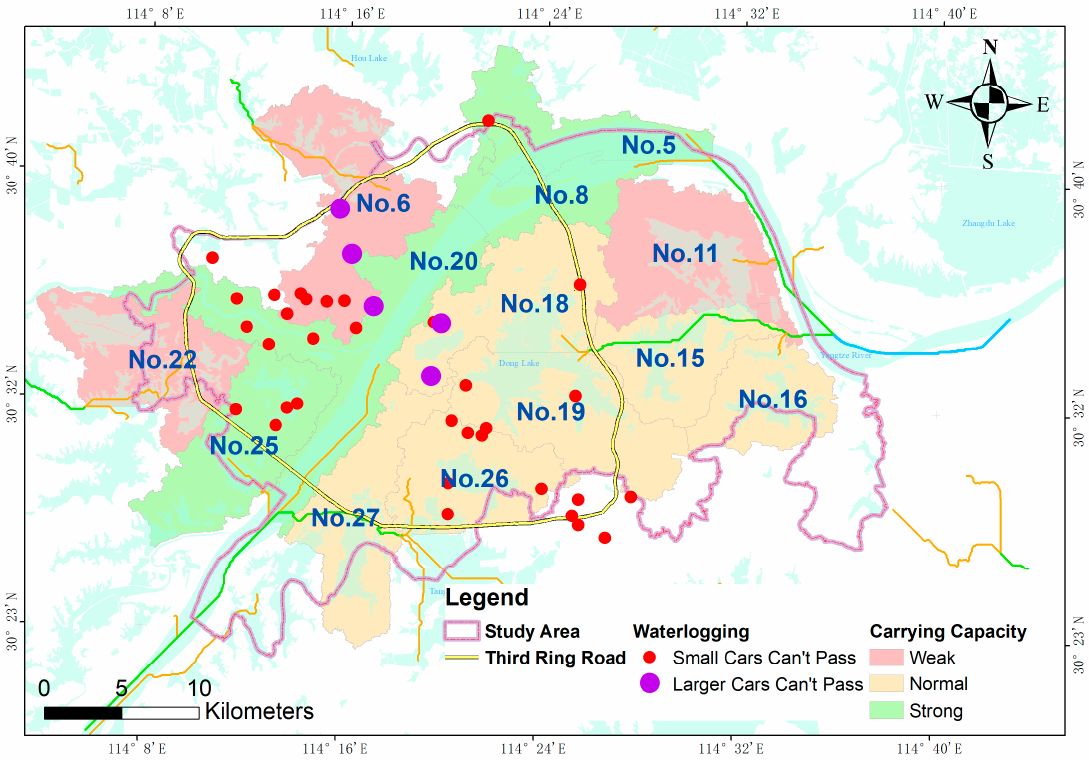
Figure 5. The typical waterlogging points distributed as overlapping the flood-carrying capacity result based on the actual data from the flood and waterlogging event which took place from June 30 to July 6, 2016. In the 30 waterlogging points, there were five points were not suitable for large motor vehicles to pass through, and 25 points were not suitable for small motor vehicles to pass through.